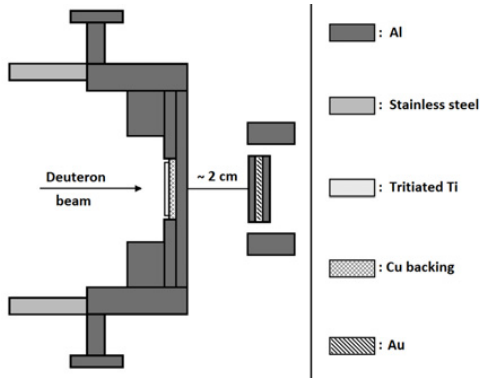
Figure 2. Schematic representation of the irradiation setup geometry.